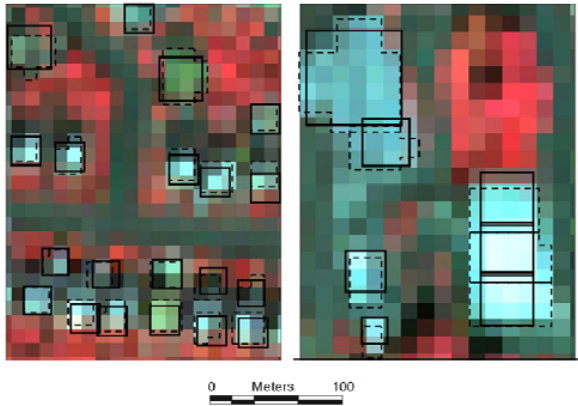
Figure 3: Structural-functional model. IKONOS image representing urban residential structure (left) and urban commercial structure (right). Postal data (POINTER database in the UK) using the area variable to represent residential function (left) and commercial function